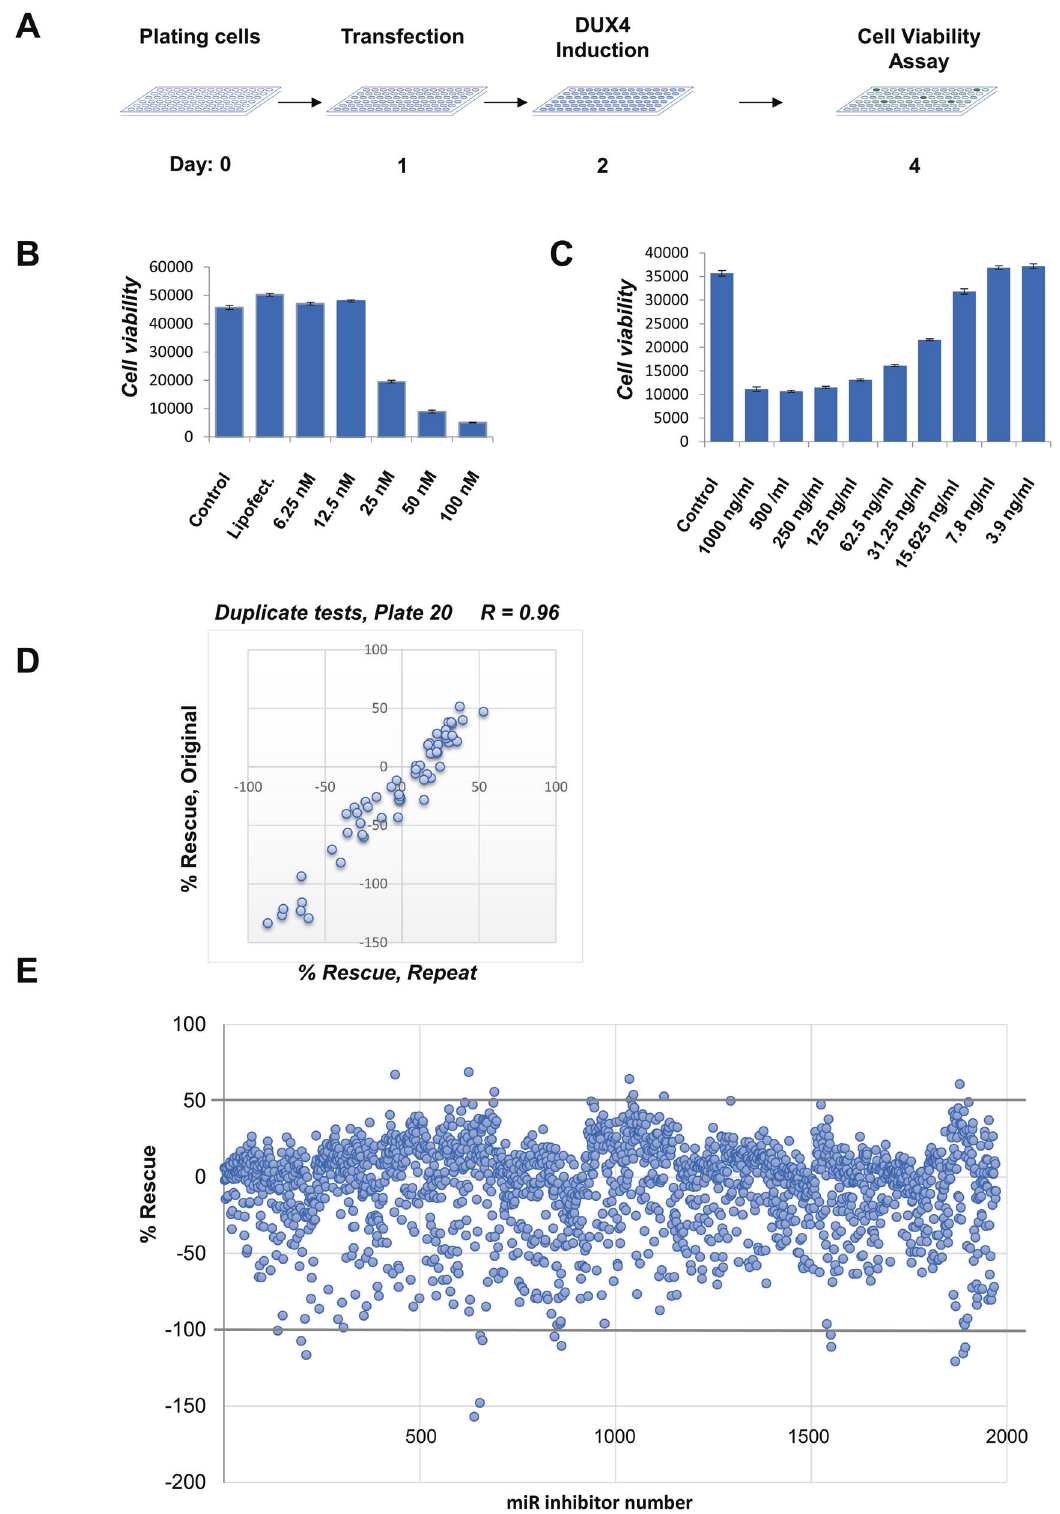
Fig. 1 miR inhibitor screen in the LHCN-M2iDUX4 cell disease model. A Timeline of the screen indicating plating of the cells at day 0, transfection of individual miRNA inhibitors into individual wells at day 1, then induction of DUX4 expression by 50 ng/ml doxycycline for 48 h followed by cell viability assay. B Optimization of the miRNA inhibitors concentration using the control toxic inhibitor. C Optimization of doxycycline induction dose. D Repeat of a single library plate showing correlation of normalized percentage of rescue scores. E Screening results for the 1972 Micro RNA inhibitor library. Normalized viability of cells exposed to 50 ng/mL dox and 50 nM micro RNA inhibitor is indicated on the y -axis.